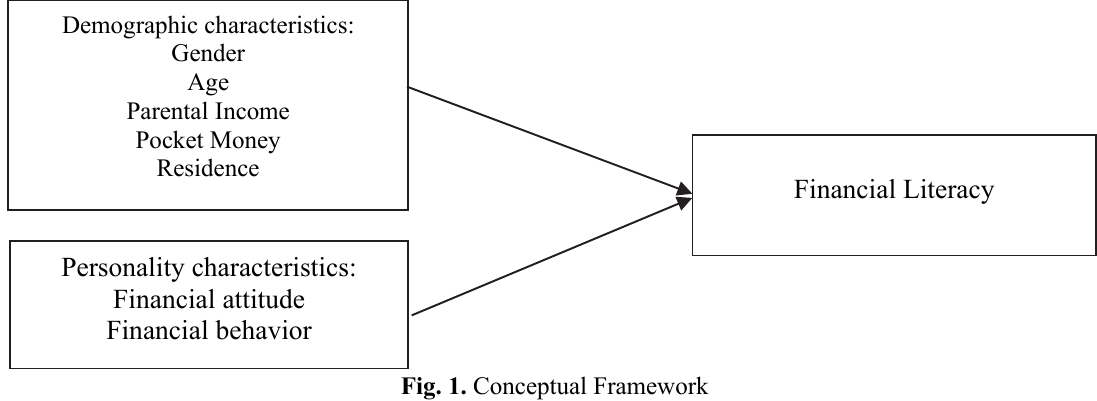
Fig. 1. Conceptual Framework